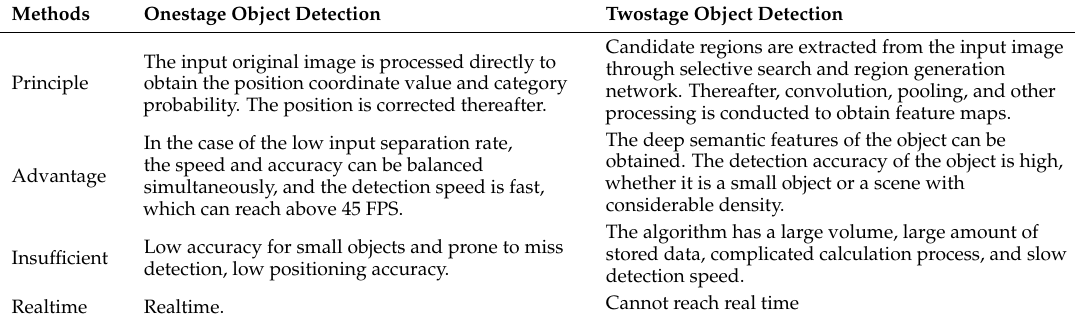
Table 3. Comparative analysis of two kinds of object detection